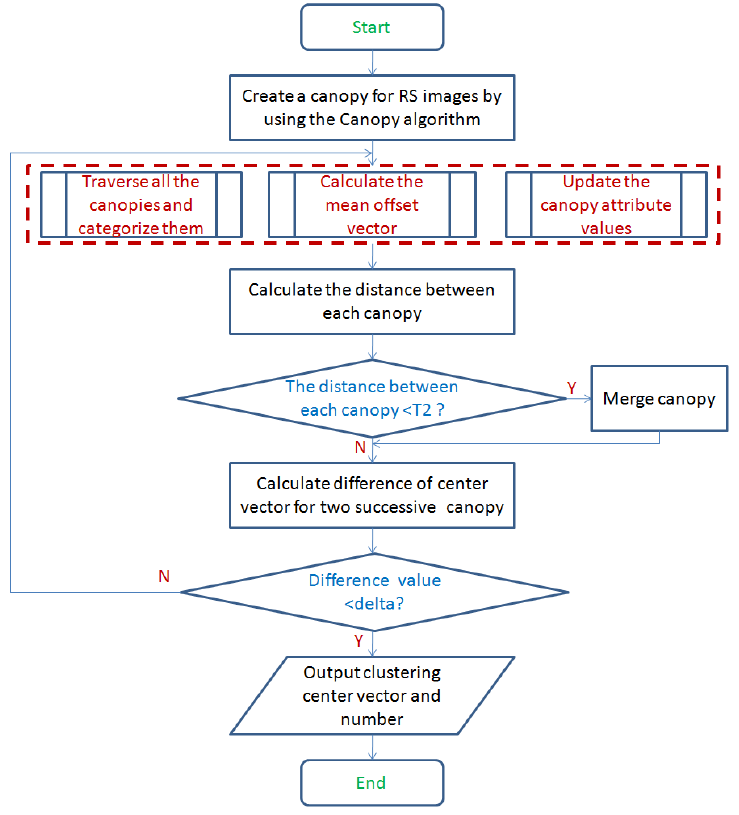
Figure 6. Flow diagram of mean-shift algorithm by modifying the canopy